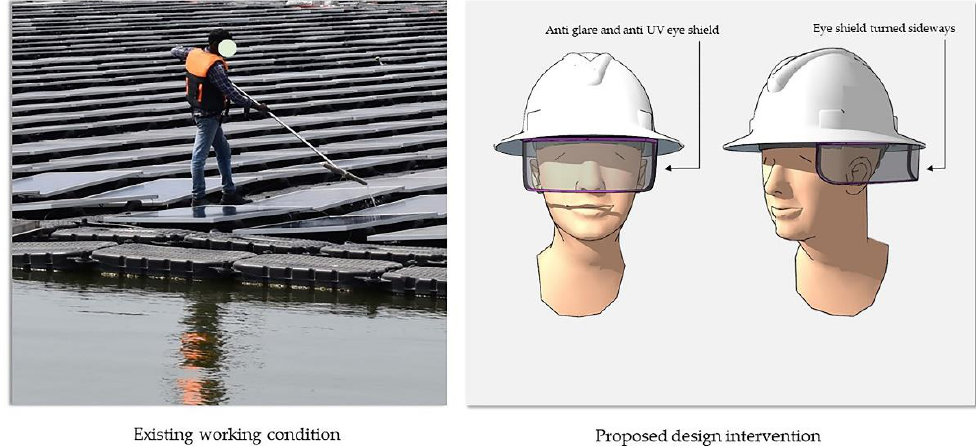
Figure 7. Design of anti-glare eye shield for use in the installation and maintenance of solar photo- voltaics projects (image: authors) .